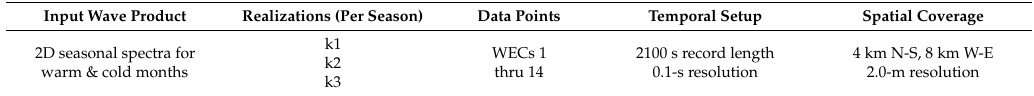
Table 1. Design of FUNWAVE model simulations.